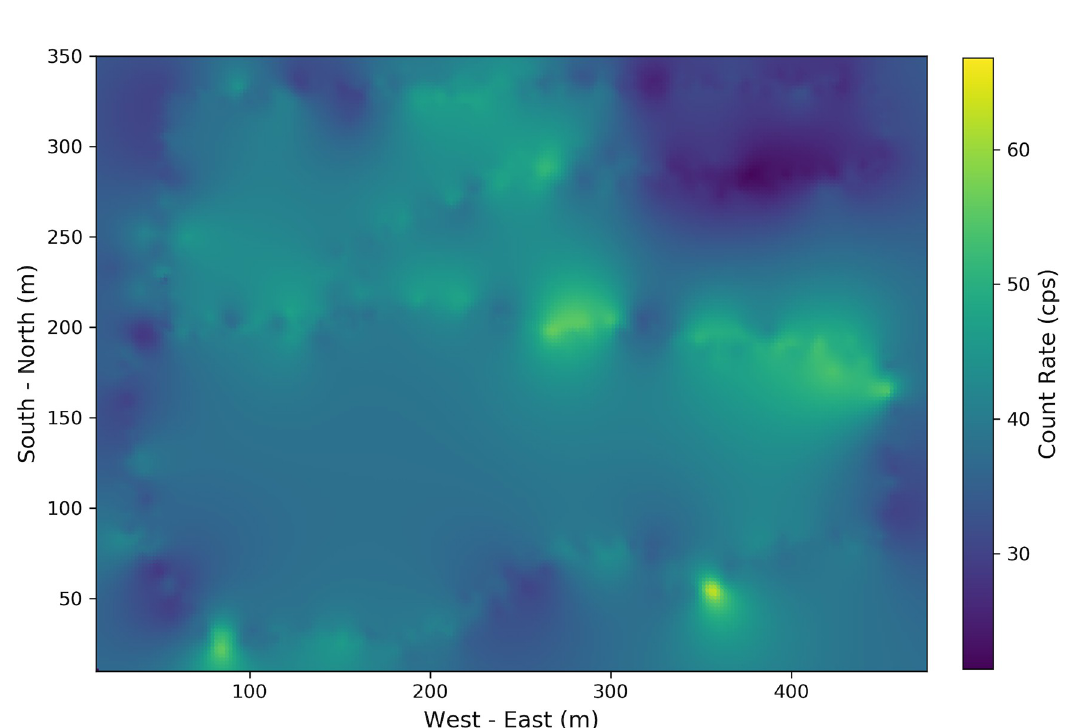
Fig 4. Poisson kriging estimation of background radiation distribution.